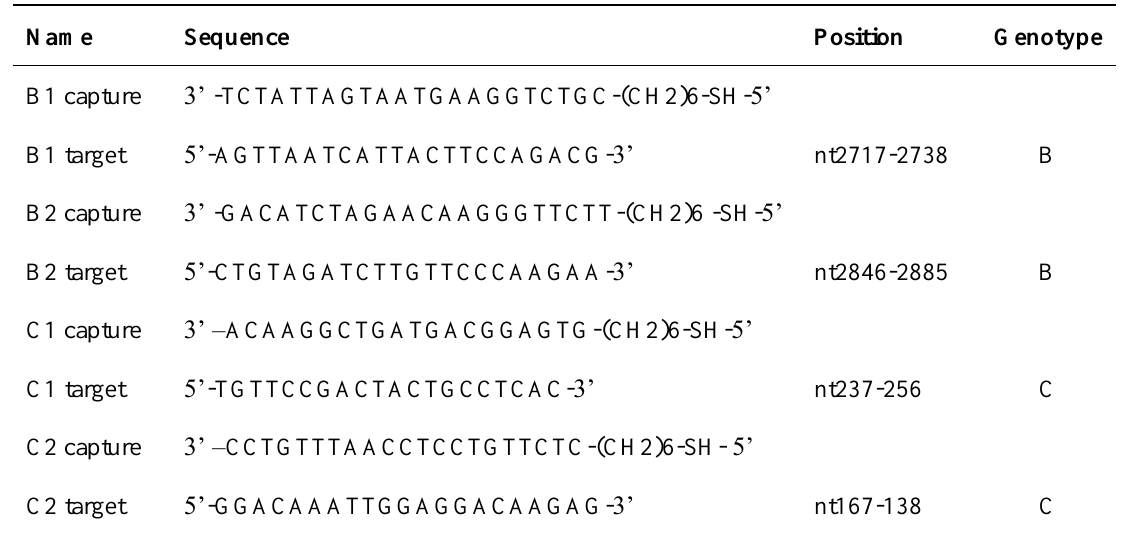
Table 1. Specific genotype probes and relative positions of their target